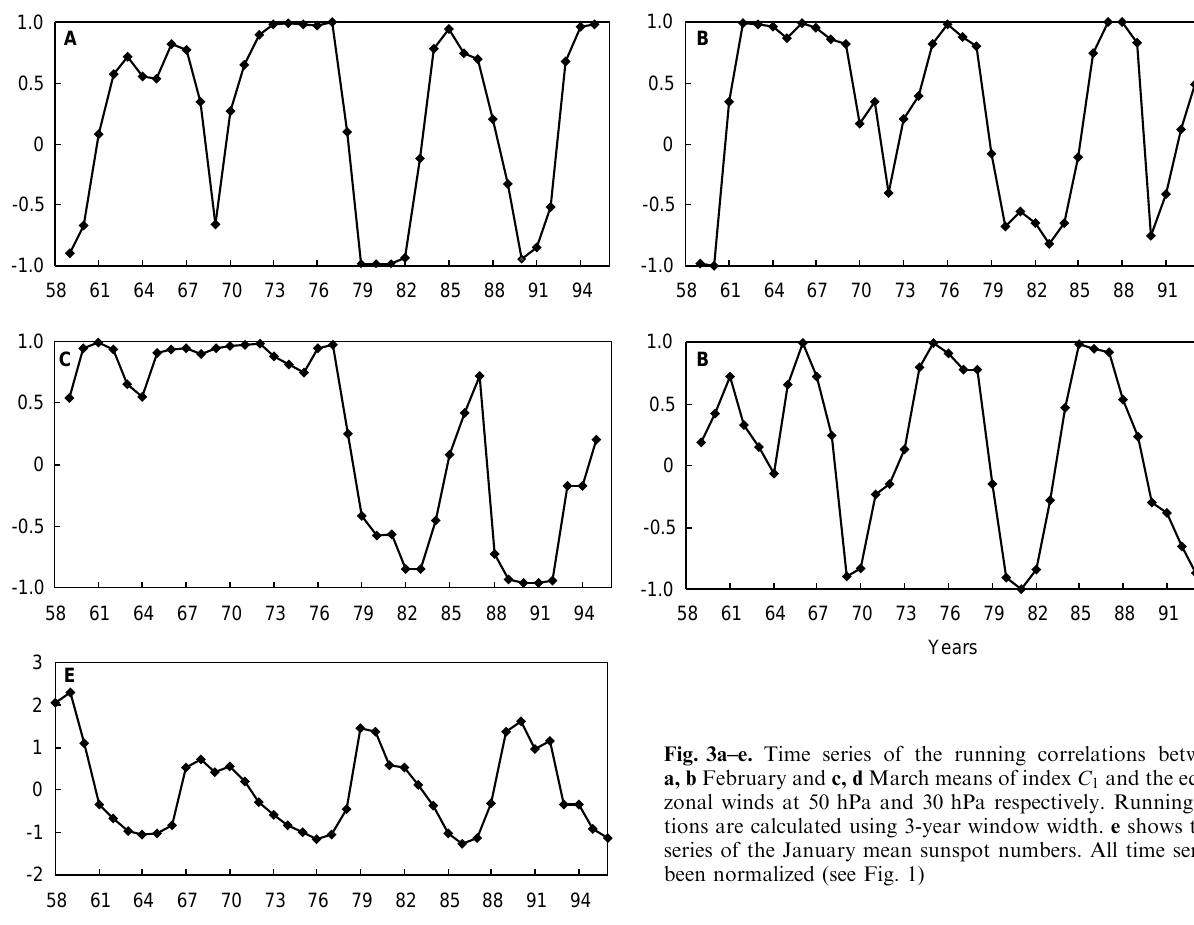
Fig. 3a–e. Time series of the running correlations between the a, b February and c, d March means of index C 1 and the equatorial zonal winds at 50 hPa and 30 hPa respectively. Running correla- tions are calculated using 3-year window width. e shows the time- series of the January mean sunspot numbers. All time series have been normalized (see